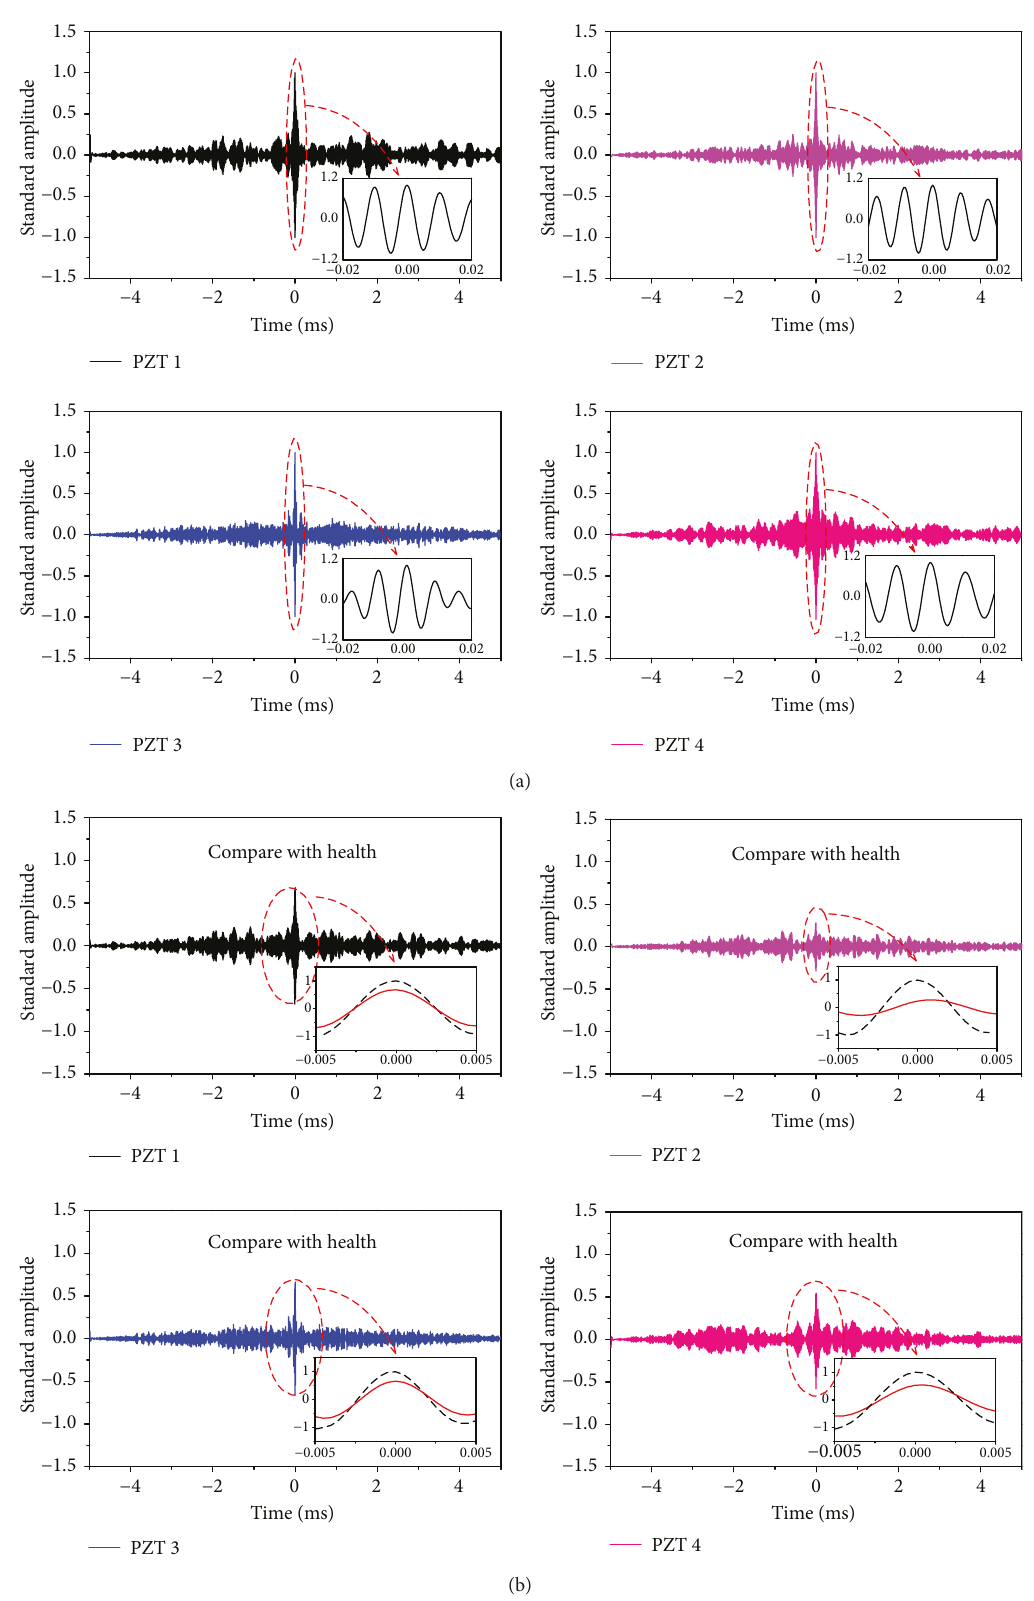
Figure 8: Experimental results using the proposed method: (a) normalized reconstructed signals for healthy structure and (b) reconstructed signals for damaged structure with joint loosening at the bracket